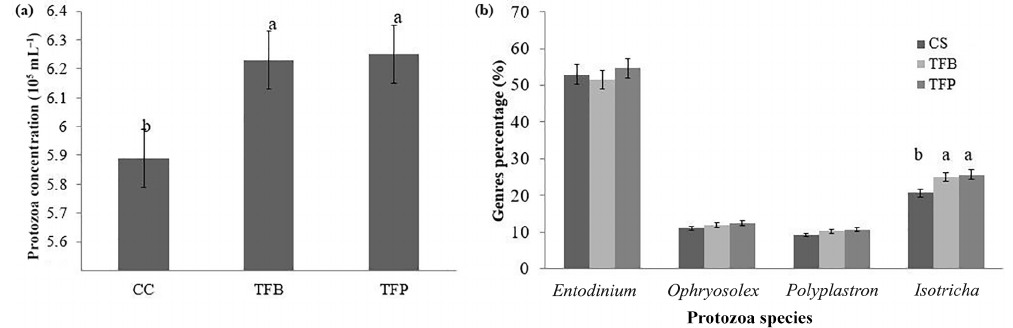
Figure 4. Total protozoa concentration (a) and different species percentage (b) 2h after feeding in the rumen of ewes according to the concentrate fed in the experimental diets (1.8kgd − 1 of oat hay + 500gd − 1 of concentrates). Within a parameter, different letters indicate differences at P <